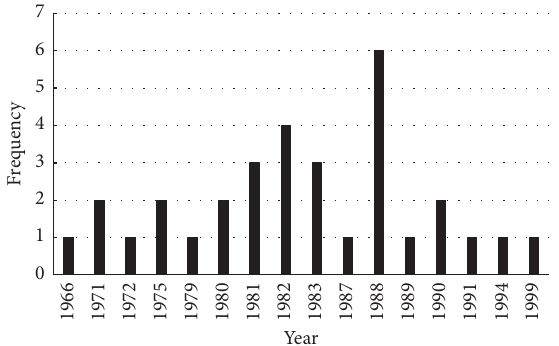
Figure 10: The frequency distribution of the change points for annual minimum temperature in 44